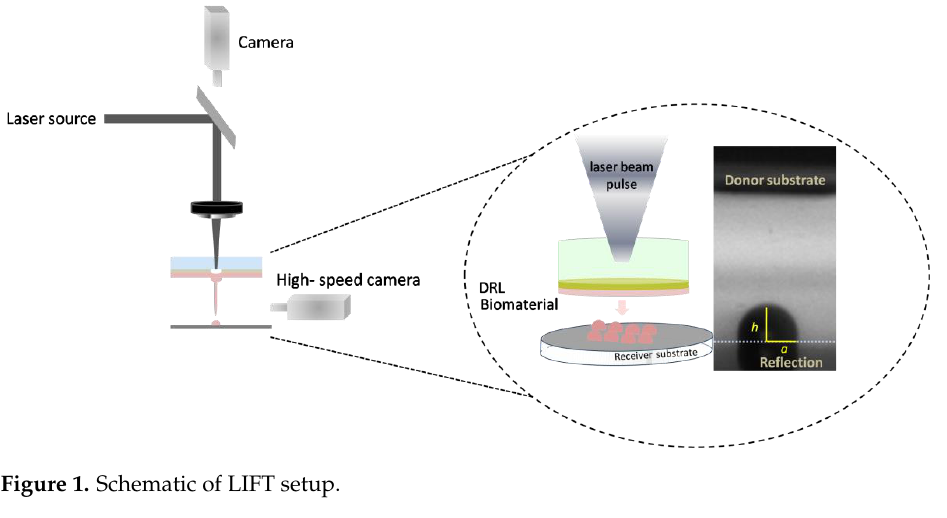
Figure 1. Schematic of LIFT